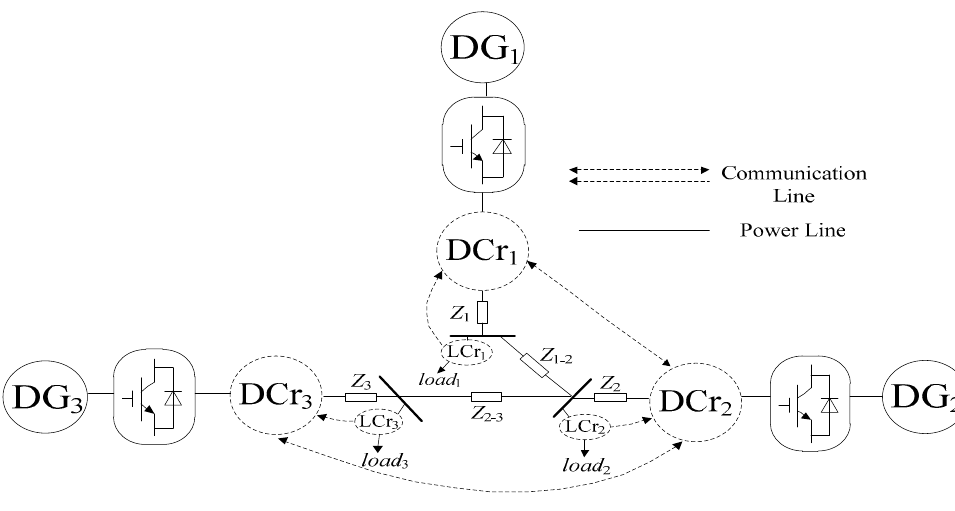
Figure 6. Structure of the AC microgrid.